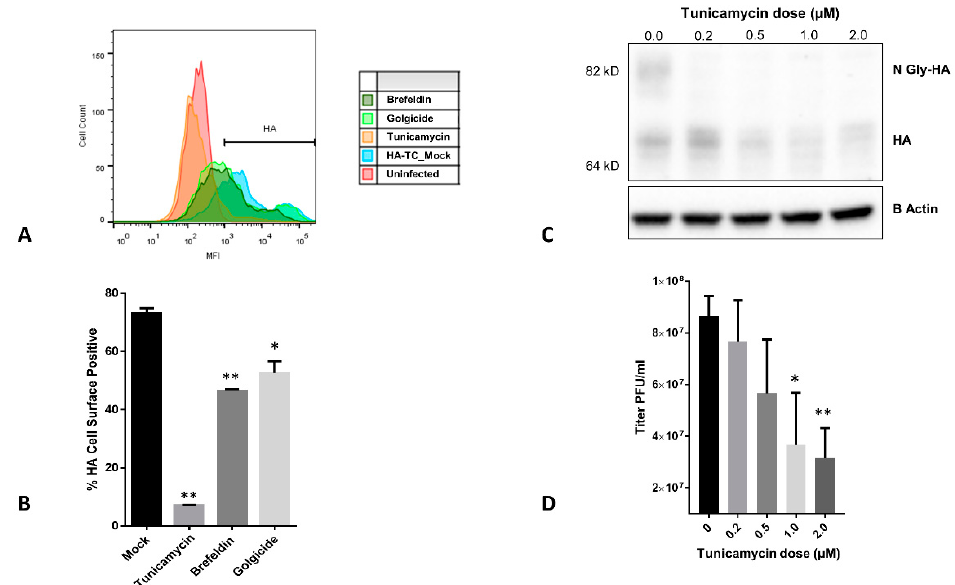
Figure 4. Inhibition of intracellular transport of HA by chemical inhibitors of ER-Golgi transport: ( A ) MDCK cells were infected with WT PR8 IAV at MOI of 2 and 3 h post infection, indicated drugs were introduced into the medium. On 9 h post infection, cells were stained with anti-HA primary and alexa-488 secondary antibody and subjected to flow cytometry. Data was analyzed using FlowJo software and Histogram shows HA signal under di ff erent conditions. ( B ) Percentage of HA positive cells from the FACS experiment were calculated and plotted on the graph. ( C ) MDCK cells were infected with WT PR8 IAV at MOI of 2 and 3 h post infection indicated drugs were introduced into the medium. On 9 h post infection, cells were harvested in SDS-PAGE bu ff er and subjected to western blotting using anti-HA and anti-Actin antibodies. ( D ) MDCK cells were infected with WT PR8 IAV at MOI of 0.02, and 3 h post infection, tunicamycin was introduced into the medium at indicated doses. Culture supernatant was harvested 48 h later, and viral titer was measured by plaque assay, as shown in the graph. Values were considered statistically significant when * p < 0.05, ** p < 0.01 and *** p < 0.001, ns > 0.05 (not significant). Data are given as mean ± SD; “n” refers to the sample size.